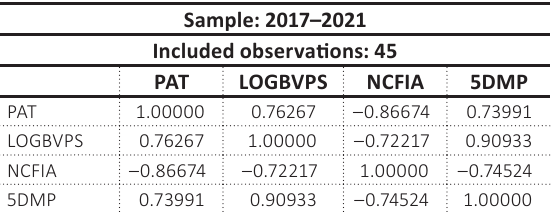
Table 2. Pearson correlation